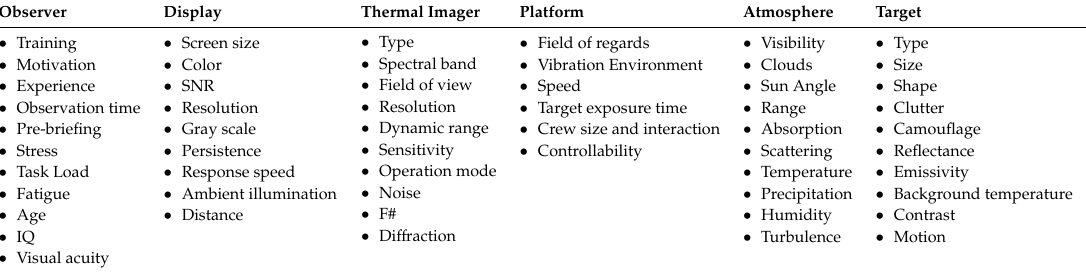
Table 1. Thermal image forming and perception influence